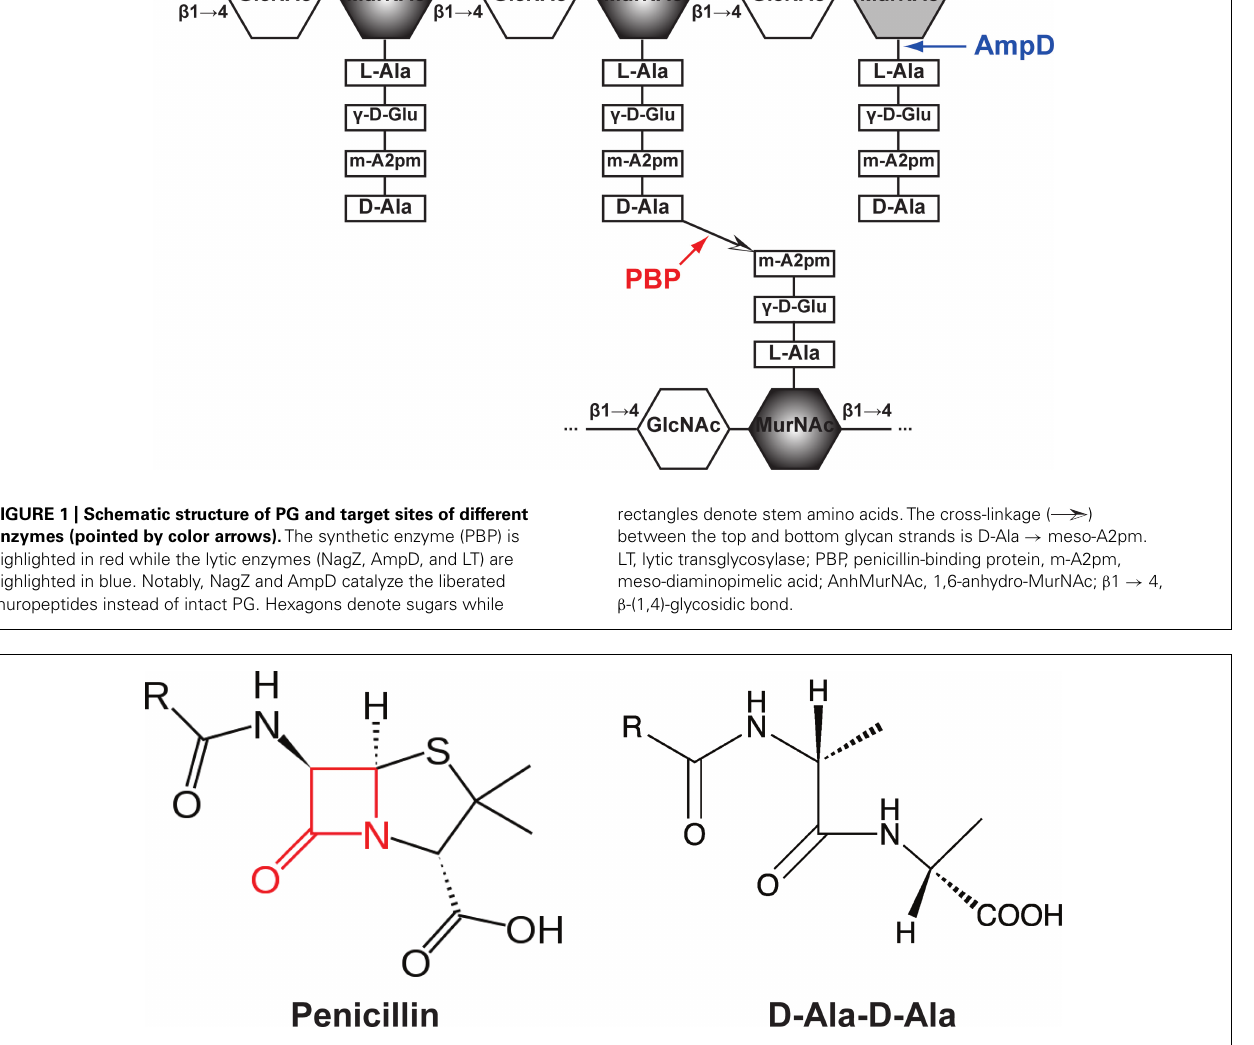
FIGURE 2 |The mimicry of beta-lactam antibiotics to D -alanyl- D -alanine ( D -Ala- D -Ala). The four-member lactam ring in penicillin was highlighted in